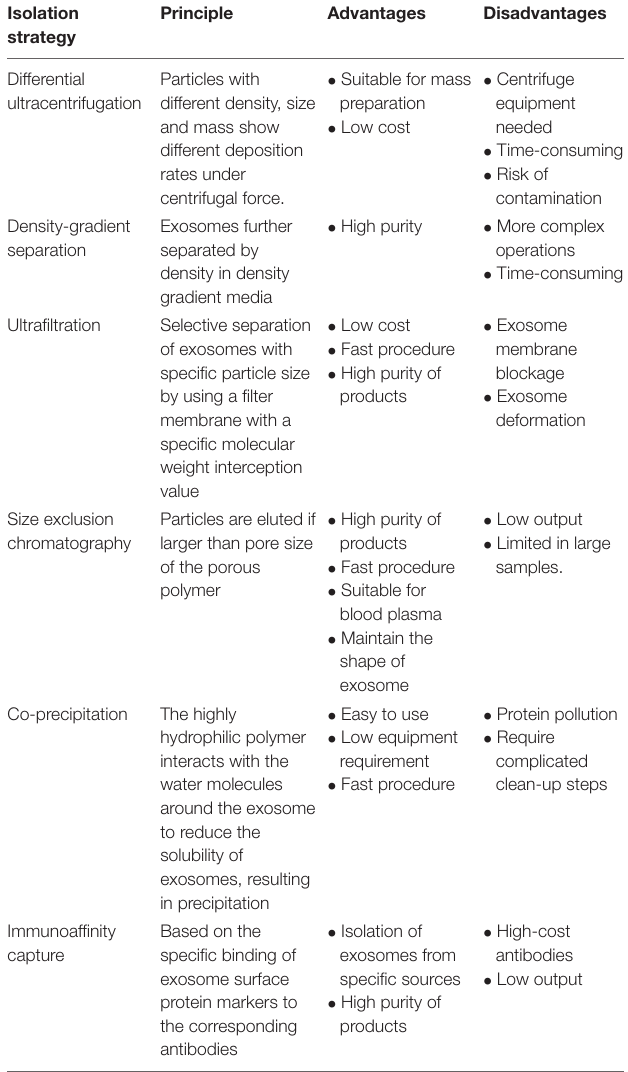
TABLE 1 | Strategies for exosome separation.